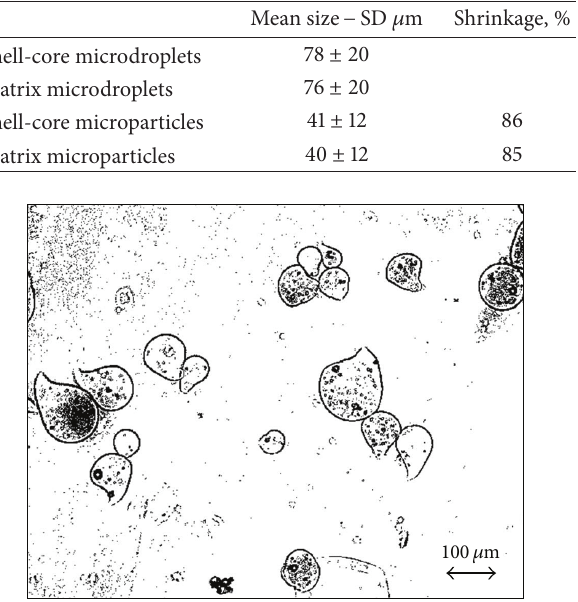
Figure 3: Optical microscope pictures of fresh shell-core micro-